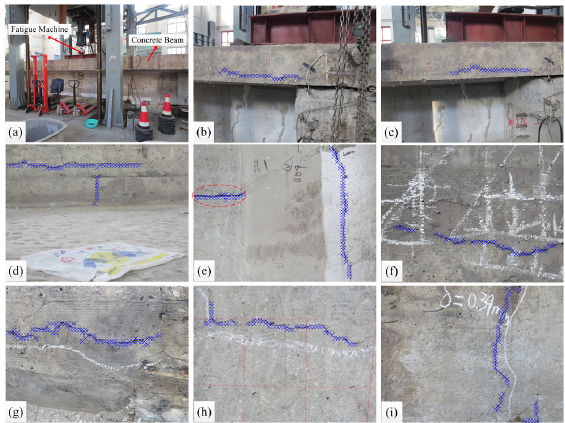
Figure 8. Representative crack damage detecting results of the field experiment: ( a ) The field environmental scene; ( b ) and ( c ) two sides of concrete beam; ( d ) the concrete bridge deck; ( e – i ) stress concentration areas. All the detected crack regions are marked with a blue X symbol.